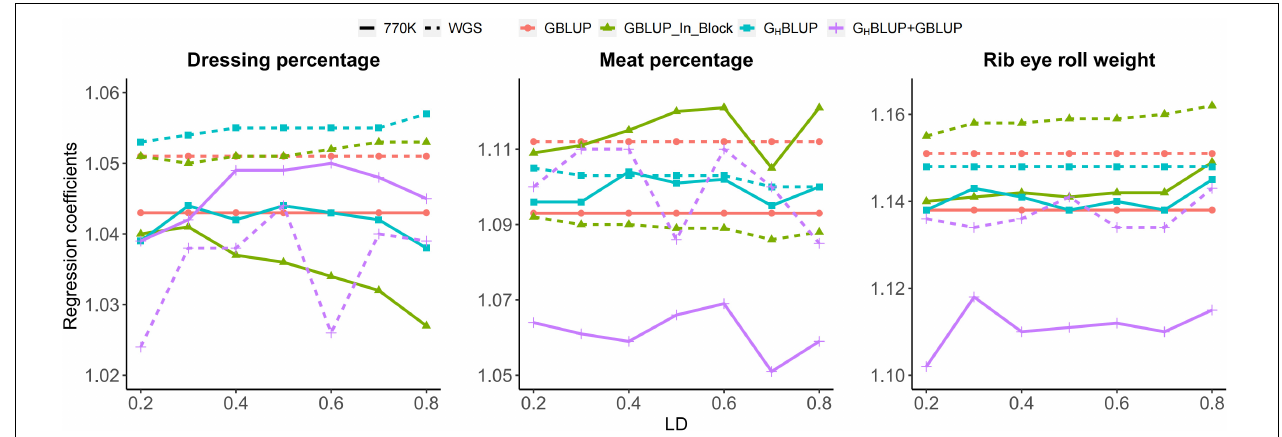
FIGURE 2 | Regression coefficients of pre-adjusted phenotypes on GEBVs for three traits in Chinese Simmental beef cattle.